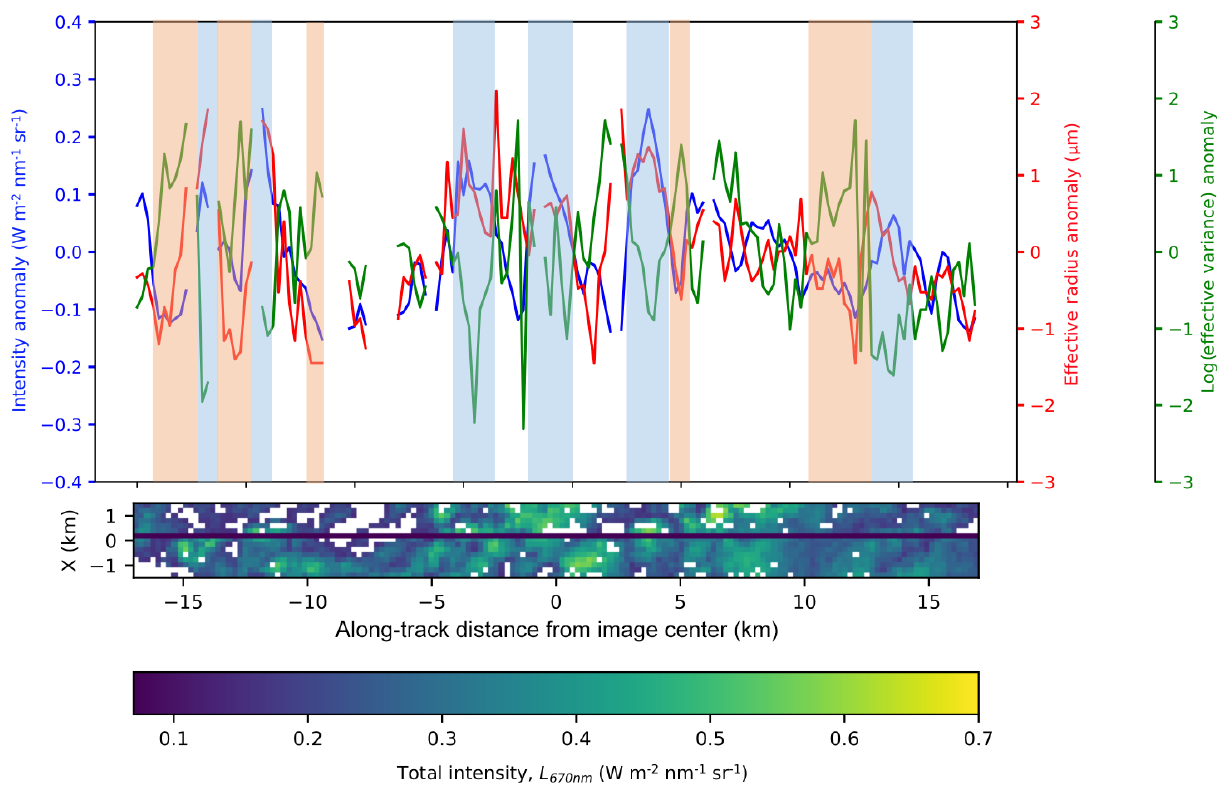
Figure 9. Analysis of intensity (blue), CDR (red), and log (CDV) (green) anomalies from the mean following the black transect along the nadir intensity push broom for a segment of the cloud field measured by AirHARP (bottom). Using the spatial distribution of intensity as a proxy for cloud optical thickness (COT), we can visually identify what appear to be cloud cores (blue blocks) and cloud periphery (orange blocks) regions. CDV trends are opposite to intensity and CDR in both regions, but wider DSDs with smaller CDR appear at cloud peripheries, while larger CDRs with narrow DSDs appear in cloud cores. The label X to the left of the intensity image is an abbreviation for cross-track distance from the image center